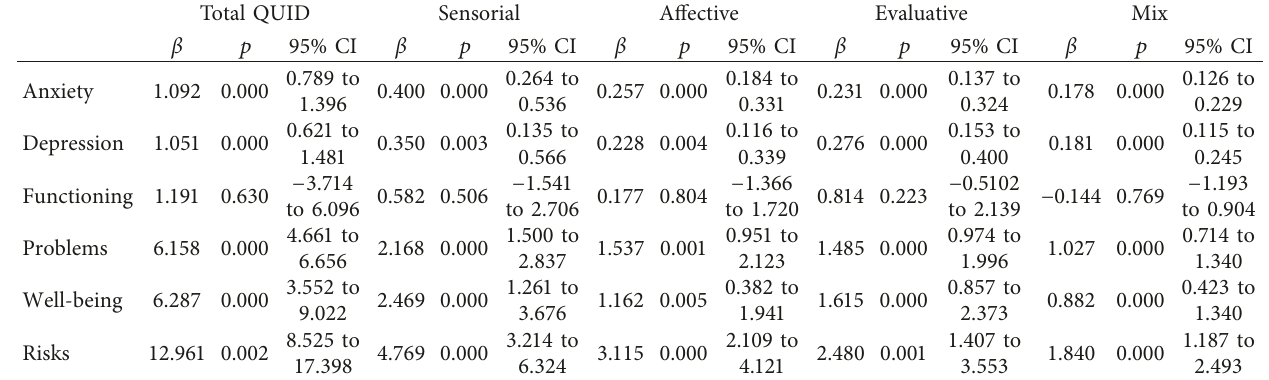
Table 2: Linear mixed